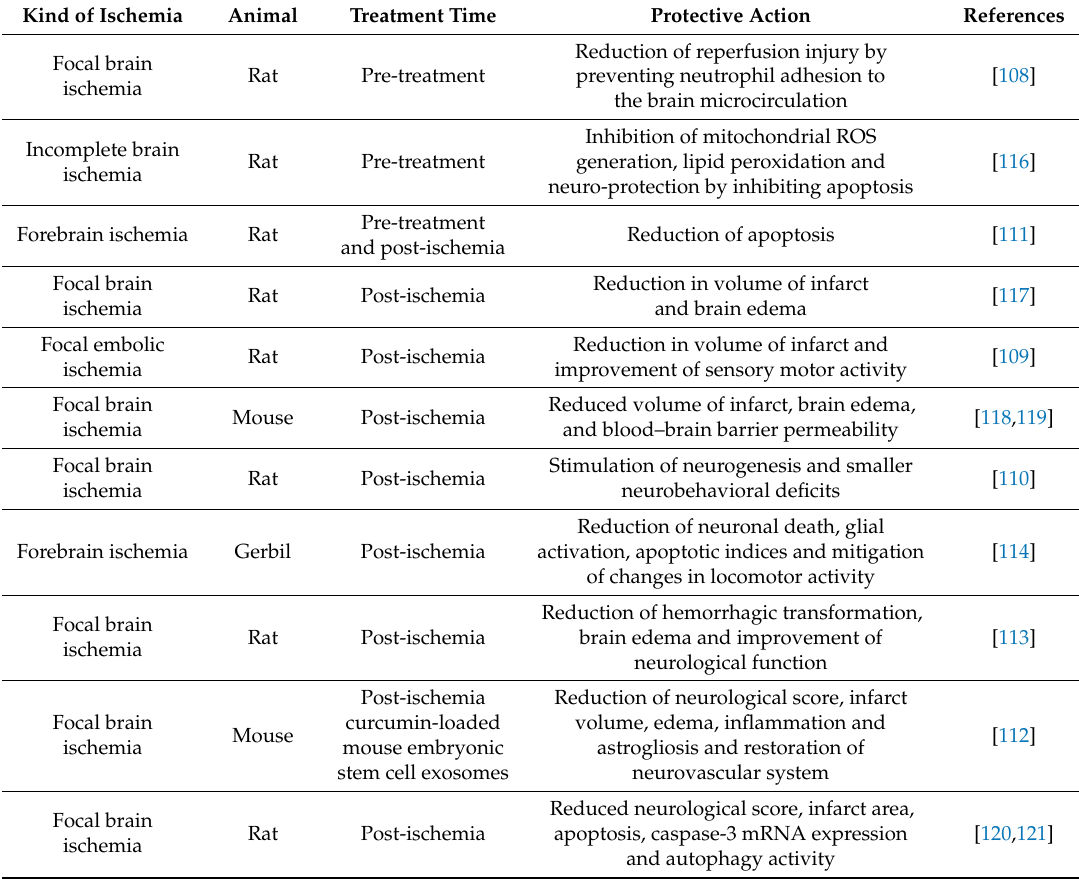
Table 1. Summary of the protective action of curcumin on post-ischemic brain damage. Kind of Ischemia Animal Treatment Time Protective